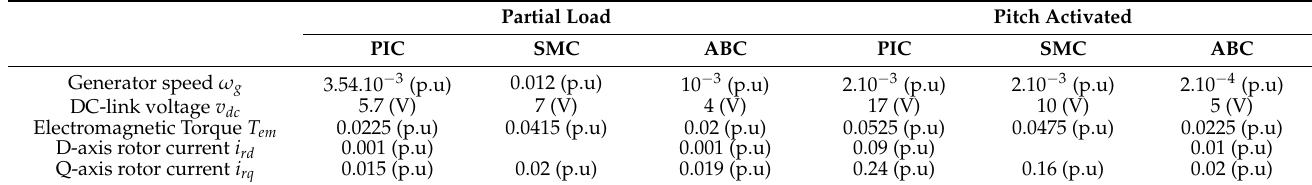
Table 1. Tracking error (ripple).